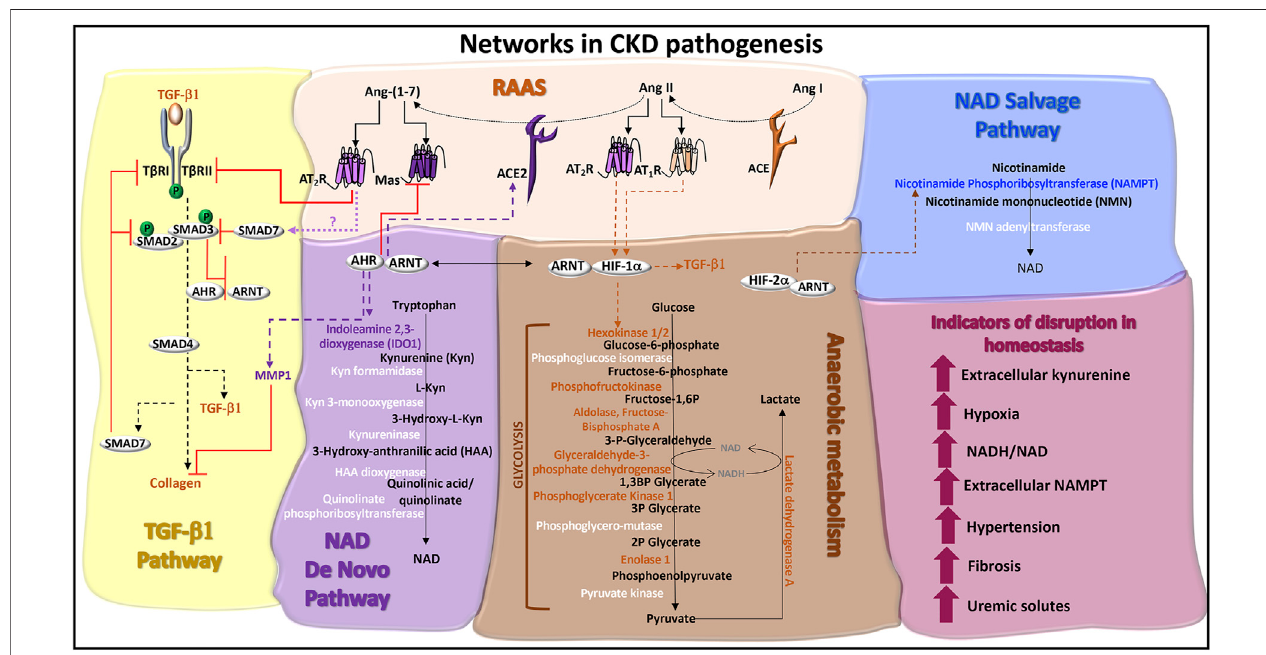
FIGURE 3 | Networks in CKD pathogenesis. TGF- β 1 pathway: TGF- β 1 signaling is initiated through serine/threonine kinase receptors, TGF- β 1 receptor (T β R)-I and T β RII. TGF- β binding to T β RII recruits T β RI to form a receptor heterodimer, which is phosphorylated. SMAD2 and SMAD3 are recruited to the receptor heterodimer andarealsophosphorylated.SMAD2andSMAD3co-localizewithSMAD4andtranslocatetothenucleustoactivategenes,suchascollagenandTGF- β 1.ACE2activity promotes the production of SMAD7, potentially via Ang-(1 – 7)-induced Mas or AT 2 R receptor signals. SMAD7 is a negative regulator of TGF- β 1 by recruiting E3 ligasestoT β RIandblockingT β RI-inducedSMAD2/3phosphorylation.LigandactivatedAHRantagonizesTGF- β 1andcollagengeneexpressionandproteinproduction, whichareassociatedwith fi brosis. Ligand activated AHR alsoinduces thedegradation ofcollagenthrough theproduction ofmatrix metalloproteinase-1(MMP1). Renin angiotensin aldosterone system (RAAS): Angiotensin I (Ang I) is cleaved by angiotensin converting enzyme (ACE) into Ang II. The binding of Ang II to AT 1 R or AT 2 R promotes the stable expression of HIF-1 α and hypoxic responses. The ACE homolog, ACE2, inactivates Ang II by cleaving and processing Ang I and Ang II into Ang- (1 – 7), which is a ligand for the Mas receptor and AT 2 R. AHR regulates the expression of ACE2 and Mas. AT 2 R activation promotes T β RII degradation, inhibiting TGF- β 1 signals. NAD de novo biosynthesis pathway (also known as the kynurenine pathway): Tryptophan catabolism is the de fi ning feature of this pathway. The rate limiting enzymes are indoleamine dioxygenase (IDO) and tryptophan dioxygenase (TDO). IDO1 is induced by AHR:ARNT transcriptional activation of the IDO promoter and promotes the production of kynurenine, which can be released as a cytokine. A series of additional enzymes (highlighted in white) catalyze the production of immunomodulatory and neuroregulatory molecules that are further processed into NAD. Anaerobic metabolism: The production of adenosine triphosphate (ATP) in the absence of oxygen occurs through enzymatic reactions in glycolysis and results in the production of lactate and the increased formation of NADH relative to NAD. Enzymes in this pathway are regulated by HIF-1 α activated genes (highlighted in orange), which can be stabilized by the RAAS. NAD salvage pathway: The primary source of mammalian NAD is from the recycling nicotinamide, which is the amide version of vitamin B3 and a by-product from the enzymatic activity of Poly-ADP-ribose polymerases (PARPs) and sirtuins. The rate limiting enzyme is nicotinamide phosphoribosyltransferase (NAMPT), which is transcriptionally activated by HIF-2 α